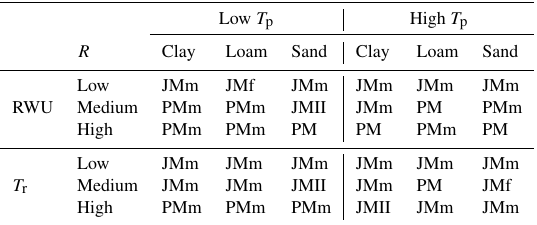
Table 6. Best models for the evaluated scenarios (root length den- sity R , soil type, and potential transpiration T p ) based on Akaike’s information criteria AIC through comparison of root water uptake (RWU) and relative transpiration ( T r ) predicted by the De Jong van Lier et al. (2013) physical model in the drying-out